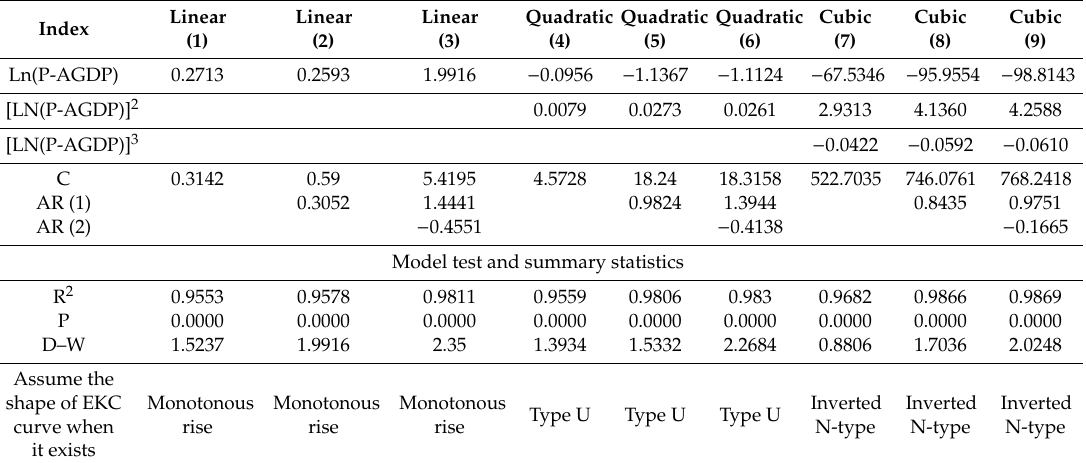
Table 7. Carbon emission model in Northwest